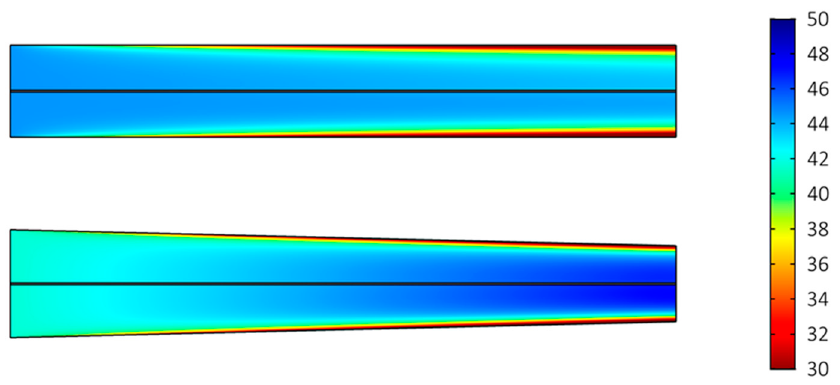
Figure 6. Minimum limiting current density (mA cm − 2 ) for Case 2 uniform 15% (top) and Case 4 variable reducing (bottom) compression configurations.